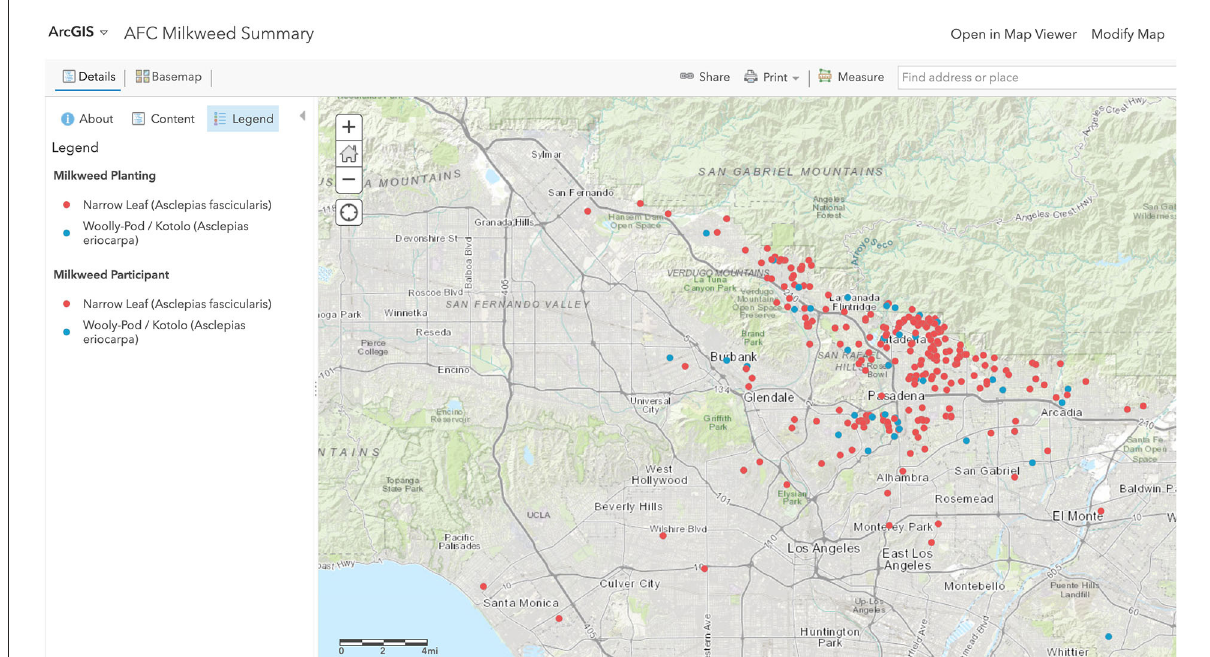
FIGURE4 Screenshot of interactive map illustrating community participation in supporting an urban wildlife corridor through planting native milkweed to support monarch butterflies. The map shows the locations and status of two native milkweed plant species distributed to volunteers and planted in backyards and neighborhoods in and adjacent to the